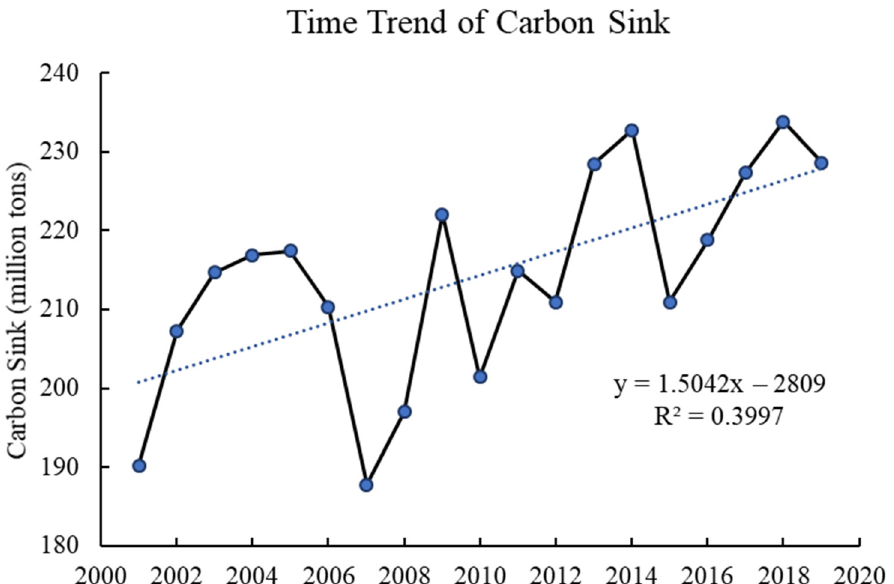
Figure 2. Time change of carbon sinks in the SOFRs in Heilongjiang Province.